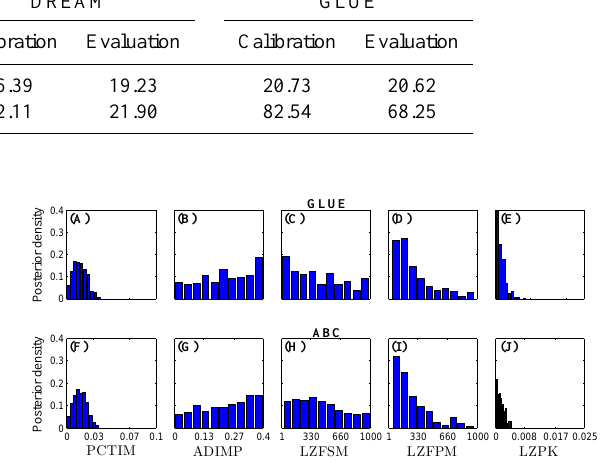
Table 6. Statistics of the GLUE, ABC and DREAM (formal likelihood function) derived posterior parameter distribution for the calibration and evaluation period of the Leaf River watershed: root mean square error (RMSE) of the posterior mean SAC-SMA simulation and coverage (%) of the associated 95% streamflow simulation uncertainty ranges. ABC DREAM GLUE Calibration Evaluation